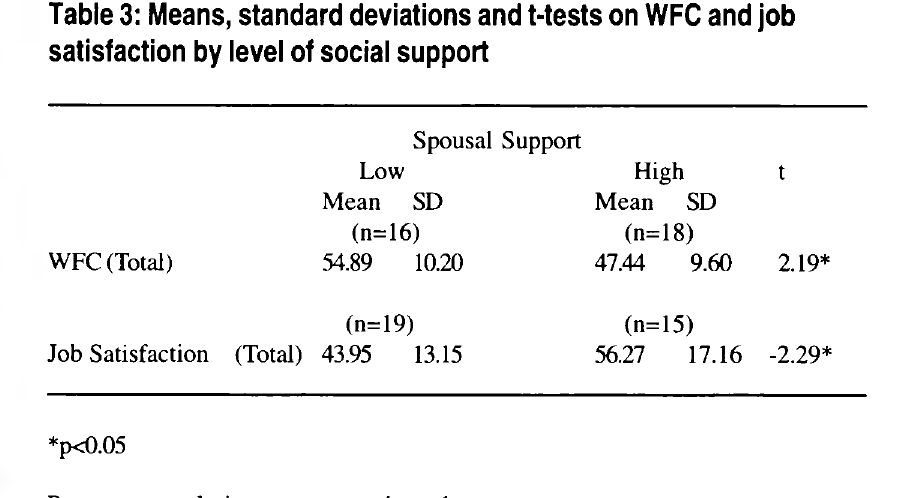
Table 3: Means, standard deviations and t-tests on WFC and job satisfaction by level of social